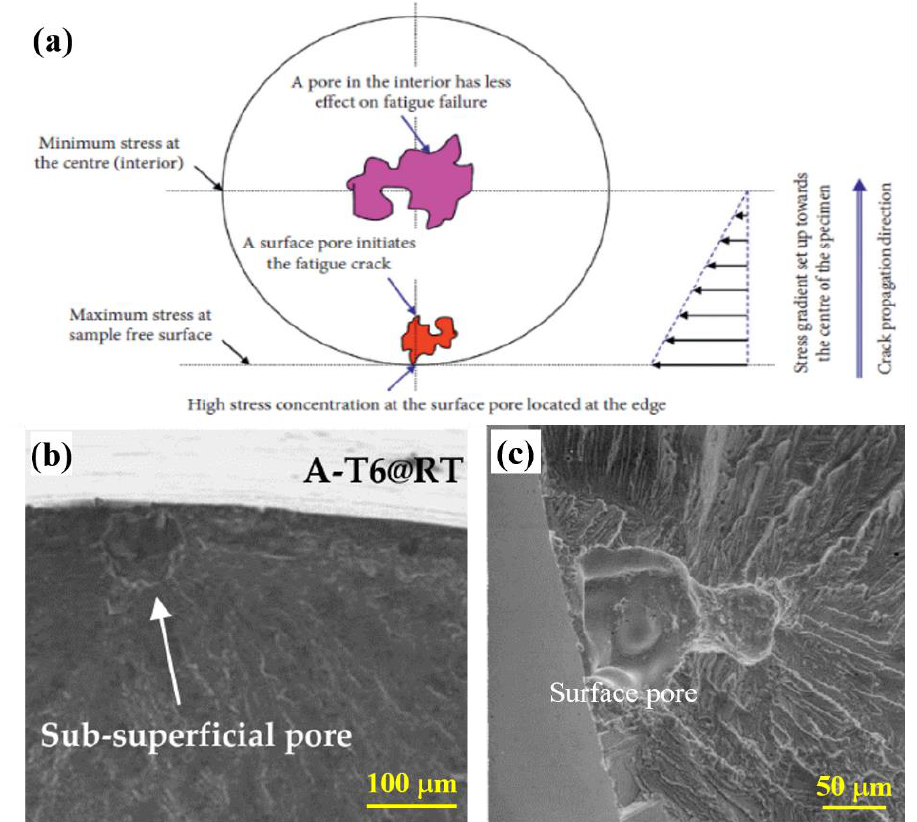
Figure 13. ( a ) Stress concentration and its gradient at the pore surface [271]. ( b ) Sub-superficial pore-inducing crack nucleation in Al-9.3%Si-2.8%Cu-T6 alloy [270]. ( c ) SEM micrographs showing sur- face pore-originating fatigue cracks in the Sr-modified A356 castings [266]. Reproduced with per- mission from Elsevier, Hindawi, and MDPI. Another parameter affecting the fatigue behavior of cast alloys is the SDAS, which reflects the effect of cooling rate during solidification. Permanent-mold and sand casting have a higher cooling rate than investment casting, resulting in finer dendrites. This re- sults in higher static and fatigue properties in the alloy fabricated through permanent mold and sand castings [72]. As fatigue properties are strongly ‘stress raiser’ -dependent, rounded and finer phases improve the fatigue life of the material [272]. As seen from Sec- tion 4.3, several modifiers, such as Sr, result in more rounded and fibrous eutectic struc- tures, leading to a significant increase in fatigue strength, even at the expense of increased porosity due to Sr addition [72]. Figure 12b shows the comparison of several S-N data under HCF loading for Al-Si alloys, with the application of a certain mean stress ( R σ −1 ). The fatigue life of A357 alloys under T6 conditions, fabricated with investment casting, (brown square) was obtained at a higher rate than that of the same alloy fabricated through permanent-mold casting (blue diamond), and this further improves upon Sr modification (magenta triangle) and HIP post-processing (red cross). This was possible